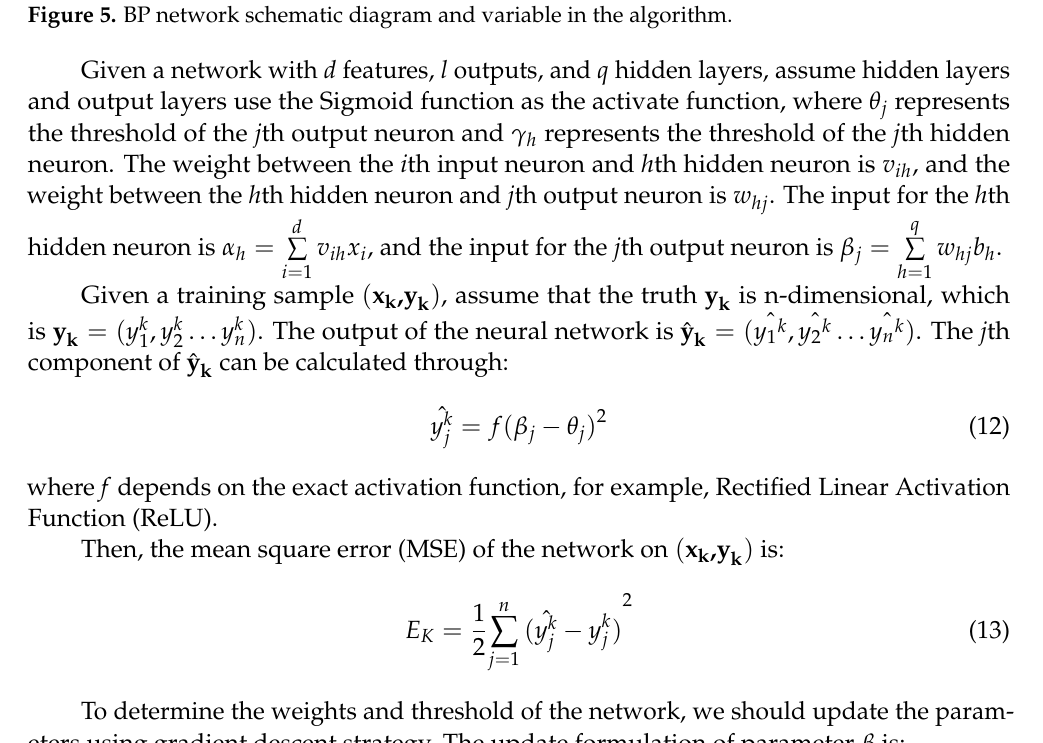
Figure 5. BP network schematic diagram and variable in the algorithm.